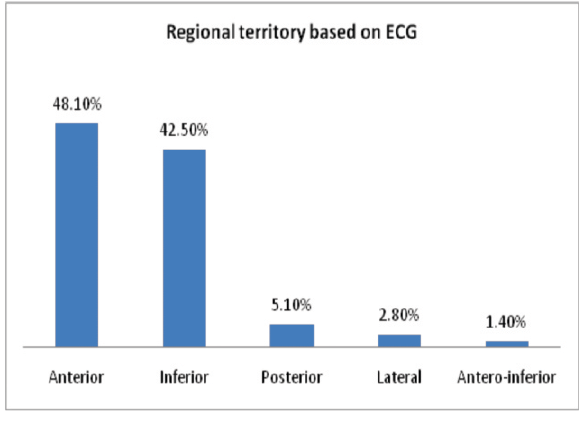
Figure 2: The regional territory of ST-elevation MI based on ECG